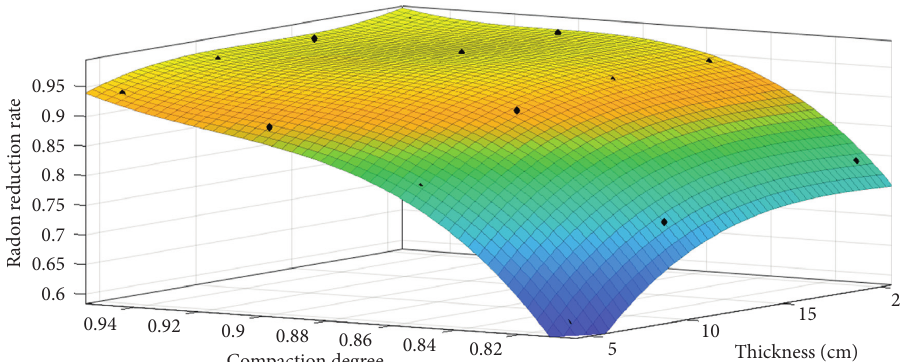
Figure 6: Relationship between the radon reduction rate and thickness and compaction